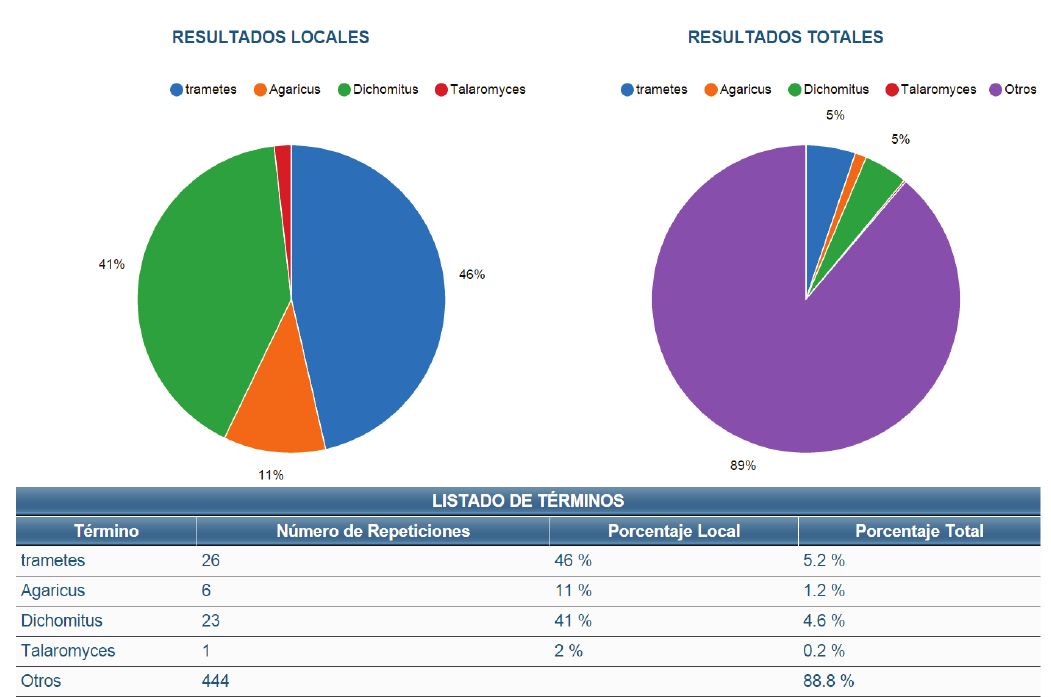
Figure 13: GITIRBio search term visualization